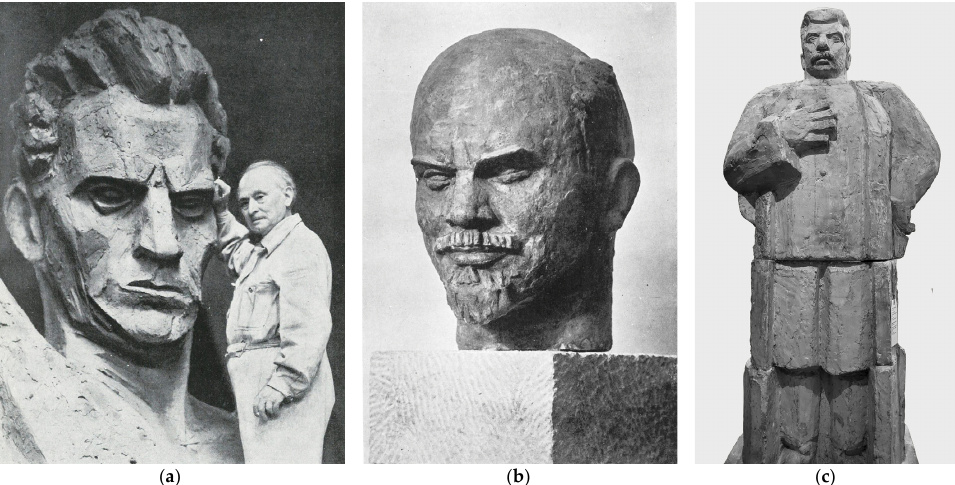
Figure 9. Xawery Dunikowski, sculptures: ( a ) “Worker’s Head”, 1946 (with artist himself); ( b ) “Lenin’s Head”, 1949 (Xawery Dunikowski i jego uczniowie 1956, pp. 19, 27); ( c ) Stalin, model, 1954 (National Museum in Warsaw, Królikarnia, photo created by authors).